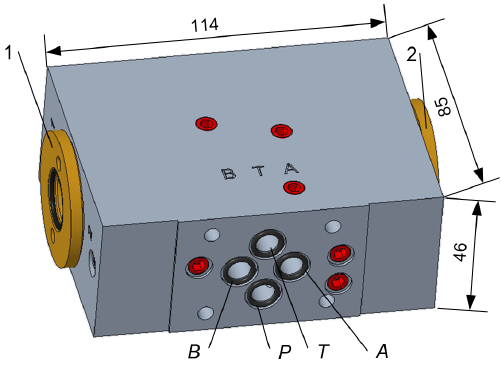
Figure 1. General view of the valve; 1, 2—electromagnet connectors, P , T , A , B —hydraulic